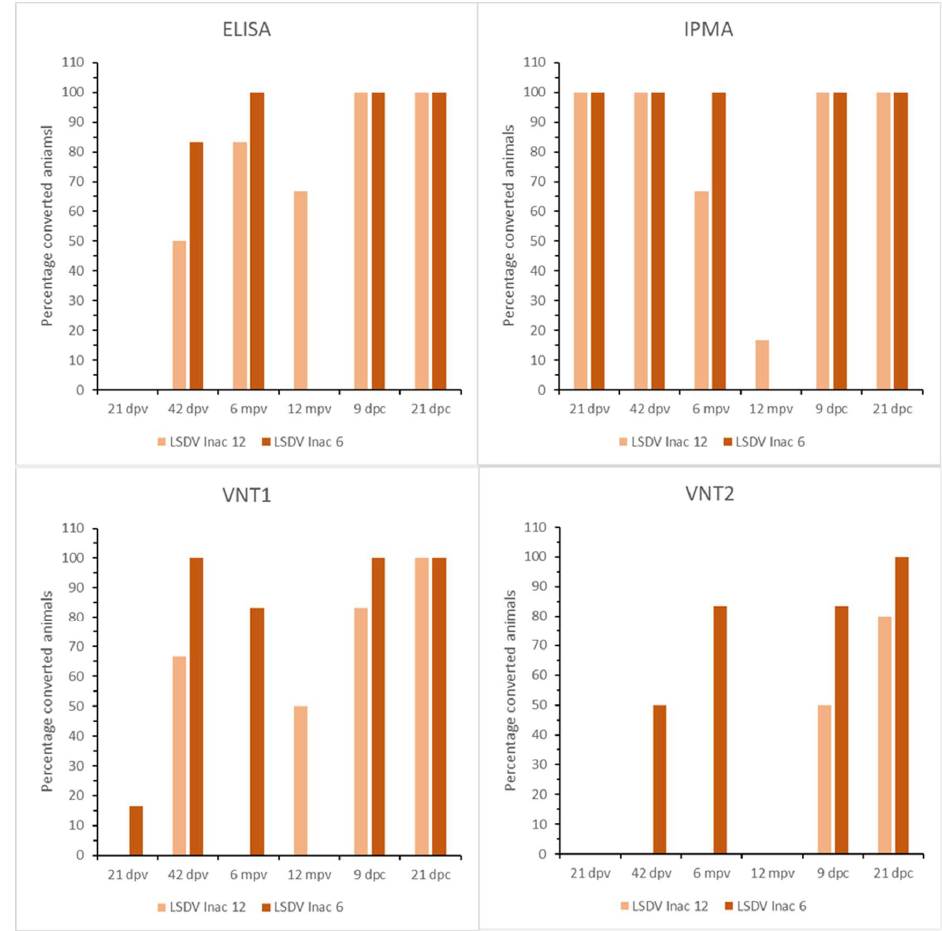
Figure 8. ELISA, IPMA, VNT1 and VNT2 results of the LSDV Inac groups.